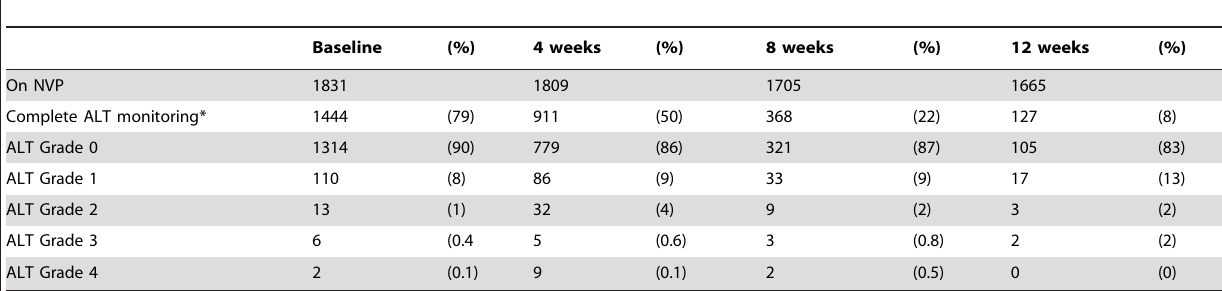
Table 2. Alanine aminotransferase for patients with complete